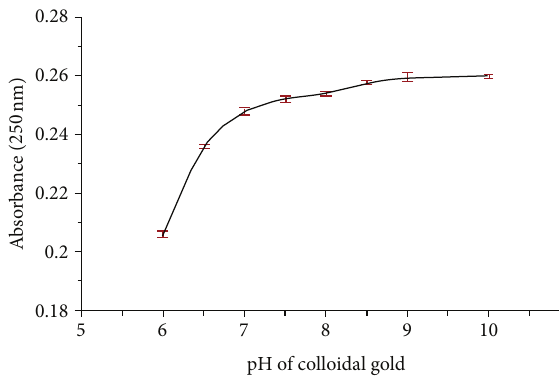
Figure 2: Optimum pH to produce a stable gold conjugate.